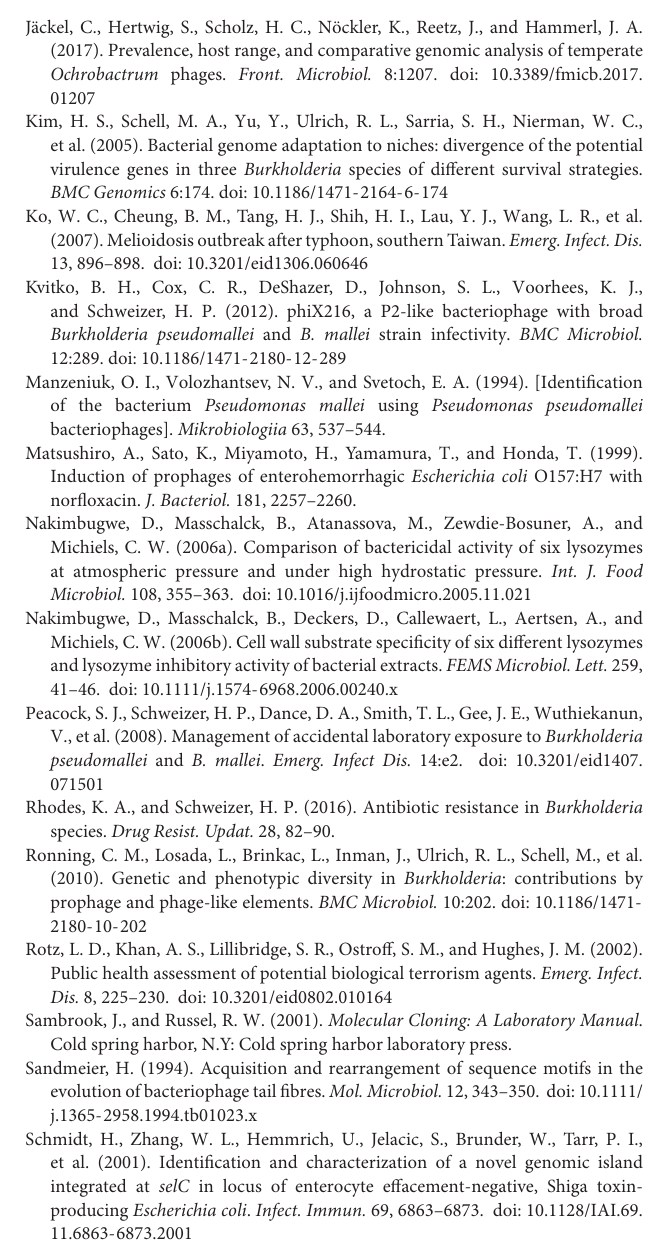
TABLE S1 | Bacterial strains used in this study. TABLE S2 | ORF analysis of the (cid:56) E067 genome. TABLE S3 | ORF analysis of the (cid:56) E058